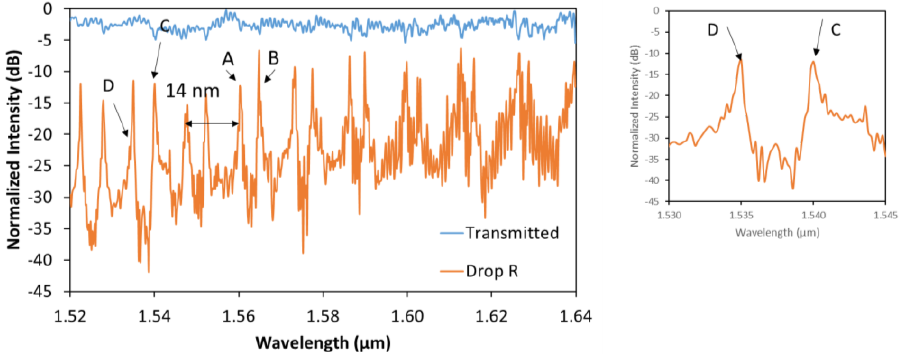
Figure 4. Experimental results for the 20 × 10 μm 2 rectangular resonator with a gap of 160 nm. The inset shows a magnification of resonance C and D.